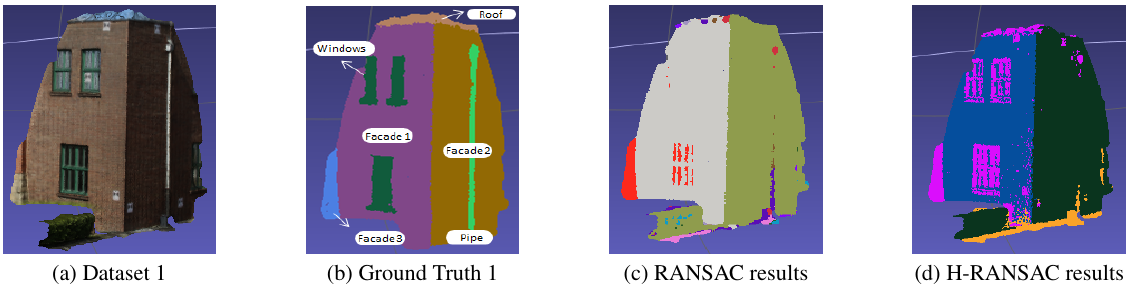
Figure 2. ISPRS / EuroSDR Benchmark for Multi-Platform Photogrammetry: a) original point cloud, b) segments obtained after manual segmentation, c) segments obtained using only geometry features, d) segments obtained using both geometry and visual